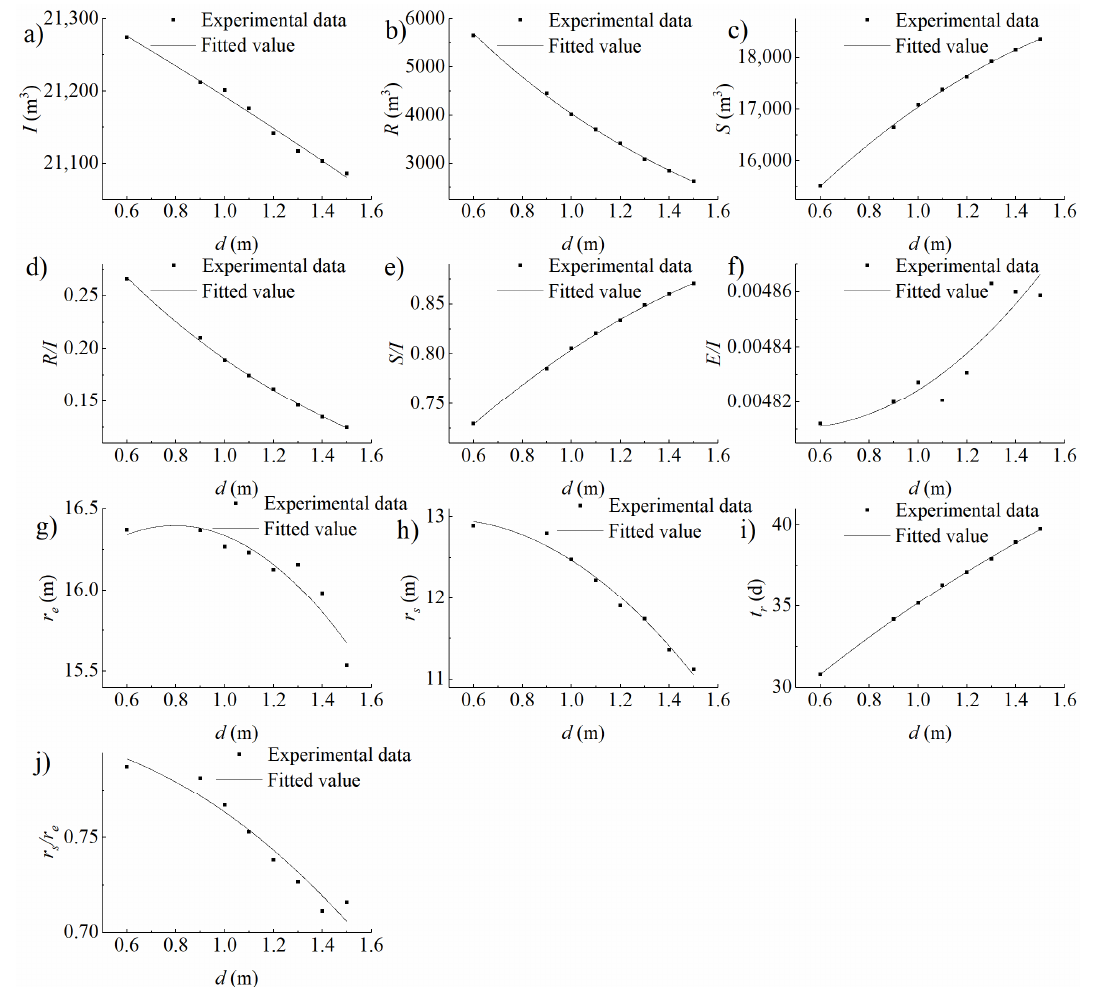
Figure 15. The variations with an increment in d when the depth is 20 m. (( a ) variation of I; ( b ) variation of R; ( c ) variation of S; ( d ) variation of R/I; ( e ) variation of S/I; ( f ) variation of E/I; ( g ) variation of r e ; ( h ) variation of r s ; ( i ) variation of t r ; ( j ) variation of r s /r e .).